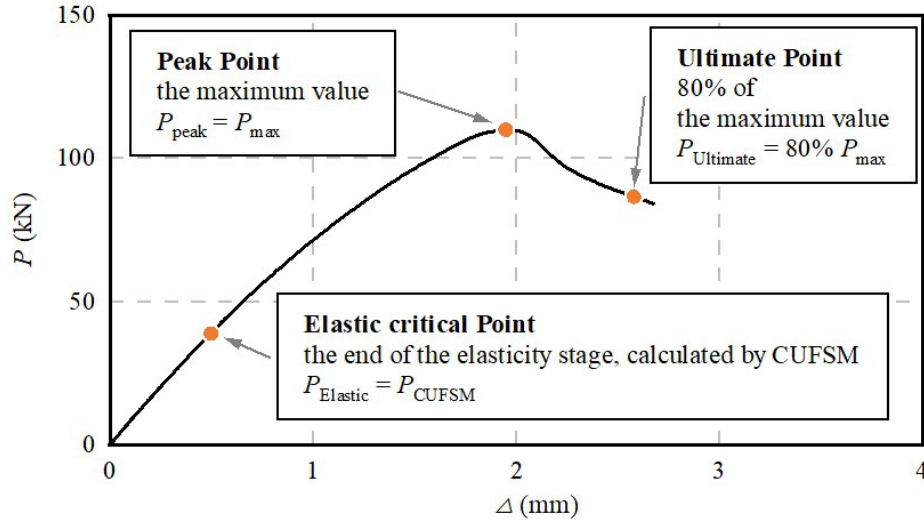
Figure 5. Schematic diagram of P—Δ curve key points.